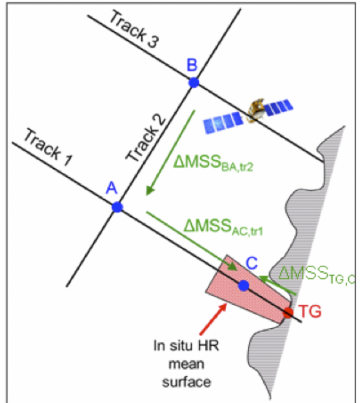
Figure 9. Generic diagram of the regional in situ calibration method. The points A and B represent the crossover points between, respectively, the satellite altimeter tracks 1 and 2, and the tracks 2 and 3. The tracks can belong to different altimeter missions. The in situ high resolution mean surface is used to link the tide gauge (TG) measurements to the altimeter data, and the comparison is done at the point C, located on this surface (adapted from